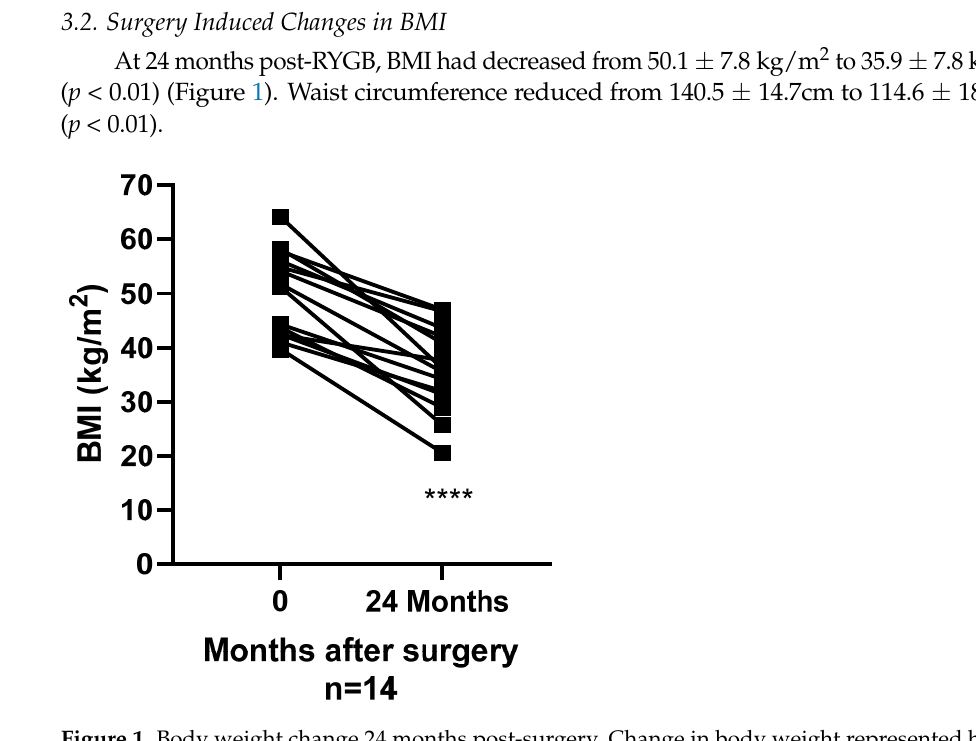
Figure 1. Body weight change 24 months post-surgery. Change in body weight represented by BMI from baseline to 24 months post-surgery. n = 14, ****: p < 0.0001, BMI Body Mass Index.